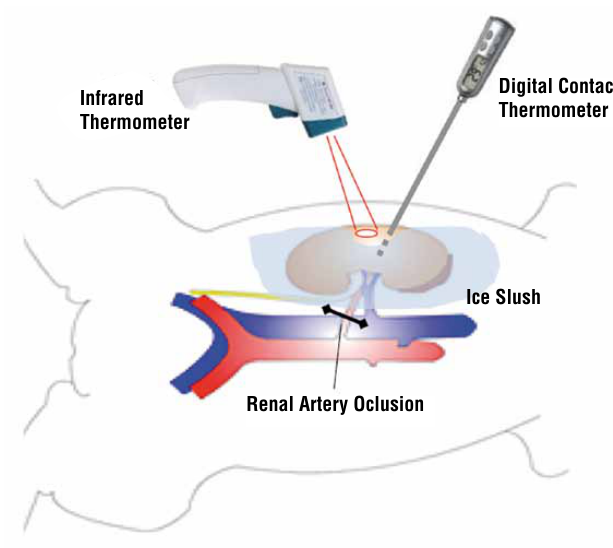
Figure 1 - Schematic Swine Model for simultaneous kidney temperature measurement with IRT and DT during renal ischemia